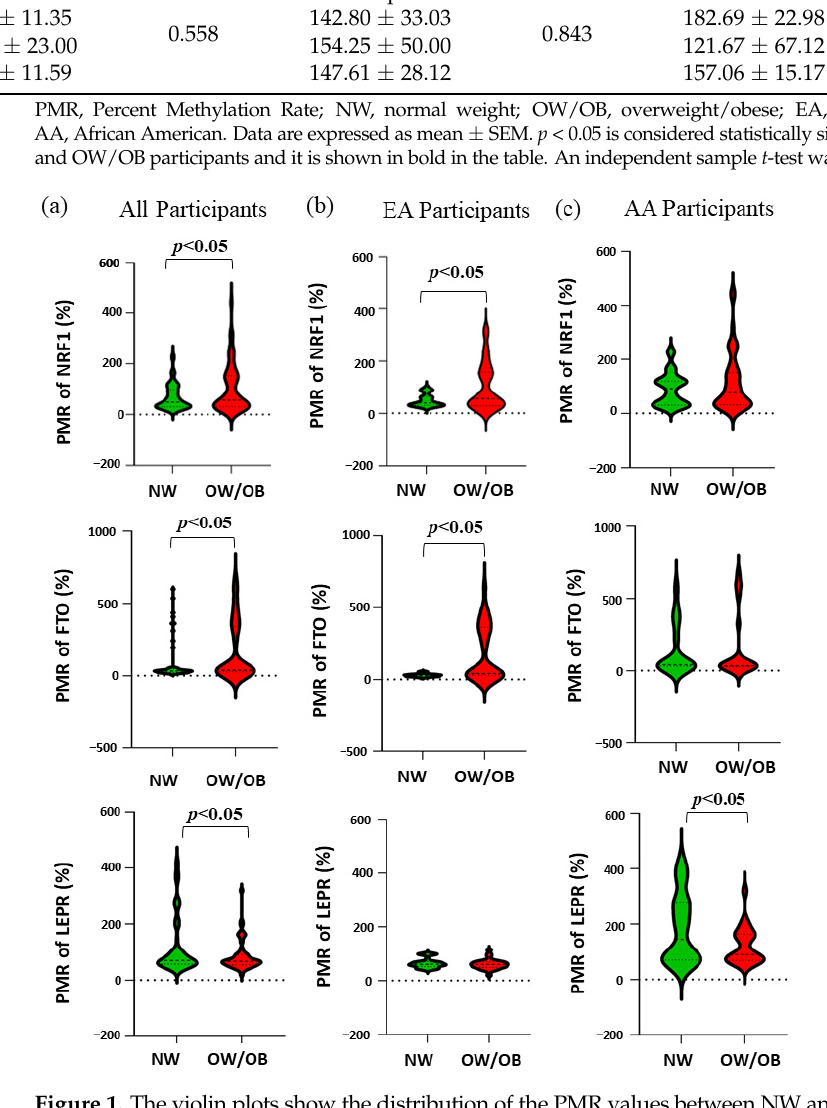
Figure 1. The violin plots show the distribution of the PMR values between NW and OW/OB children. ( a ) The PMR of NRF1 between NW and OW/OB children in all, EA, and AA participants. ( b ) The PMR of FTO between NW and OW/OB children in all, EA, and AA participants. ( c ) The PMR of LEPR between NW and OW/OB children in all, EA, and AA participants. p < 0.05 is considered statistically significant. A multinominal linear regression between PMR of NRF1 , FTO , and LEPR with the obesity measures (BMI z -score, WC z -score, and WHtR z -score) after adjusting with the covariates (family income and maternal education) demonstrated a significant positive correlation between PMR of NRF1 in EA participants with BMI z -score in the adjusted and unadjusted model. Meanwhile, AA participants showed a negative correlation between PMR of NRF1 and obesity measures with no statistical significance (Table 5). Similar calculations were performed for PMR of FTO and obesity measures. For EA participants, a significant positive correlation was observed with the BMI z -score, WC z -score, and WHtR z -score for both adjusted and unadjusted models. While AA participants, there is a negative correlation with no statistical significance of FTO with obesity measures (Table 6). For the gene LEPR , total participants and EA showed no significant association while in AA, BMI z -score, and WtHR z -score had a significant negative association with LEPR for both adjusted and unadjusted models. Interestingly, we could see a significant negative association between the WC z -score and PMR of LEPR only in the adjusted model